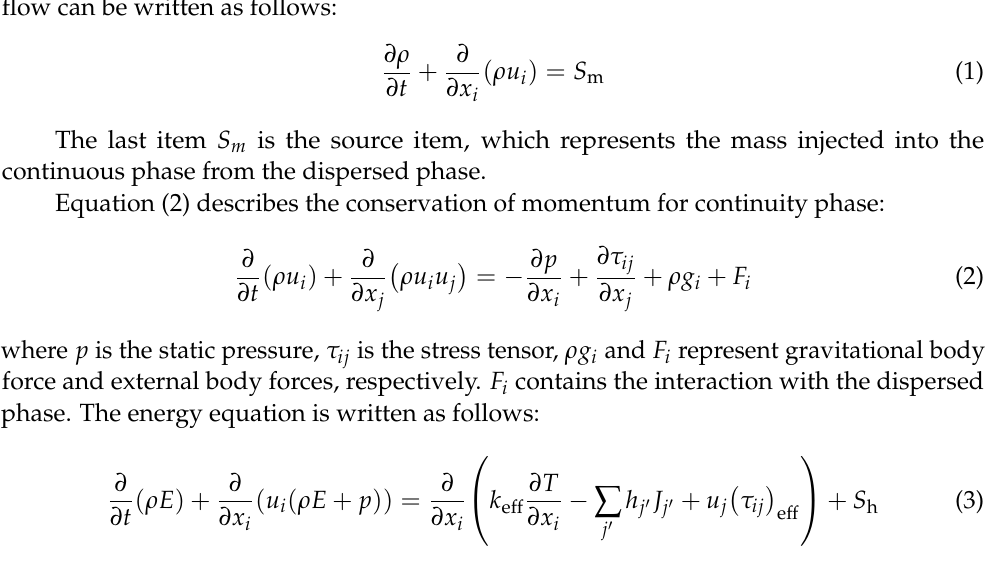
the cone direction was kept on the X-axis. The angle between the injection direction and X-axis was set to θ = 75 ◦ . The Rosin–Rammler law was used for the diameter distribution of droplets, the minimum, maximum and mean diameters were set as 10 µ m, 30 µ m and 50 µ m, respectively.